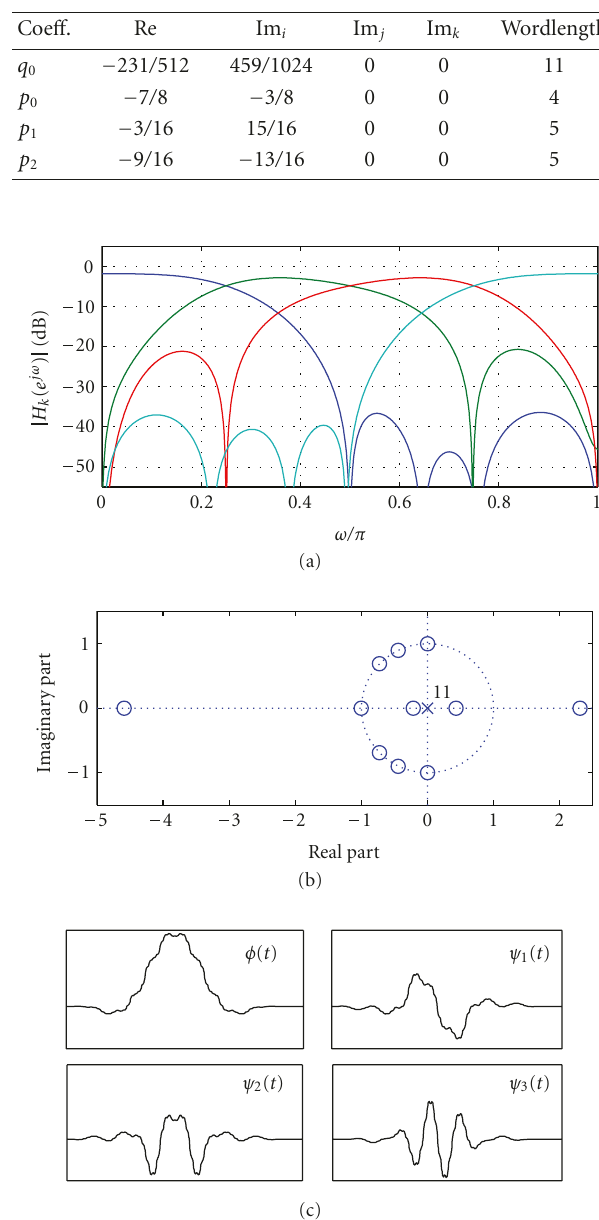
Figure 11: Design example of LP PUFB: (a) magnitude responses, (b) zeros of H 0 ( z ), and (c) the scaling function and